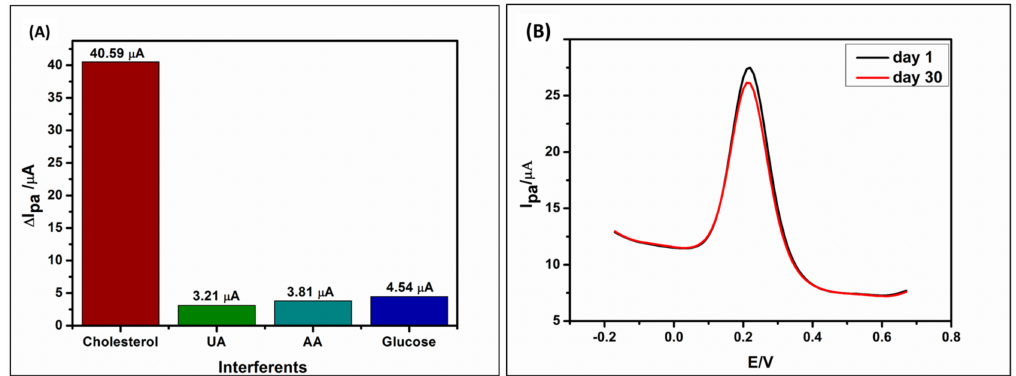
Figure 7. Selectivity of the biosensor (GCE/PPI/QDs/ChOx) in the presence of 5 mM cholesterol and interferents—10 mM uric acid (UA), 10 mM ascorbic acid (AA) and 10 mM glucose in PBS (pH 7.2) solution ( A ). Stability studies of the biosensor at day 1 and day 30 in 5 mM cholesterol solution at pH 7.2 ( B